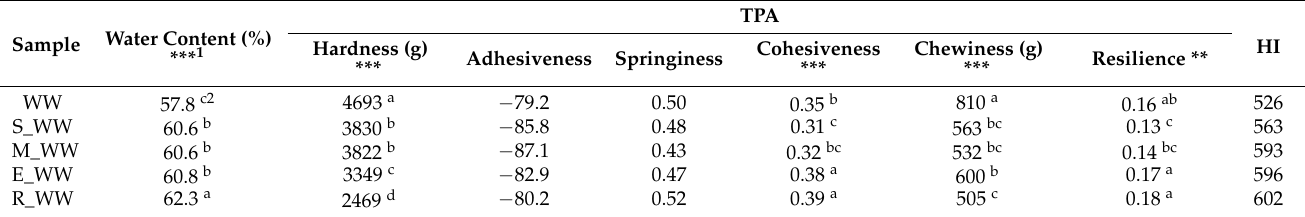
Table 1. Water content, TPA and HI of cooked rice samples with various processed whole